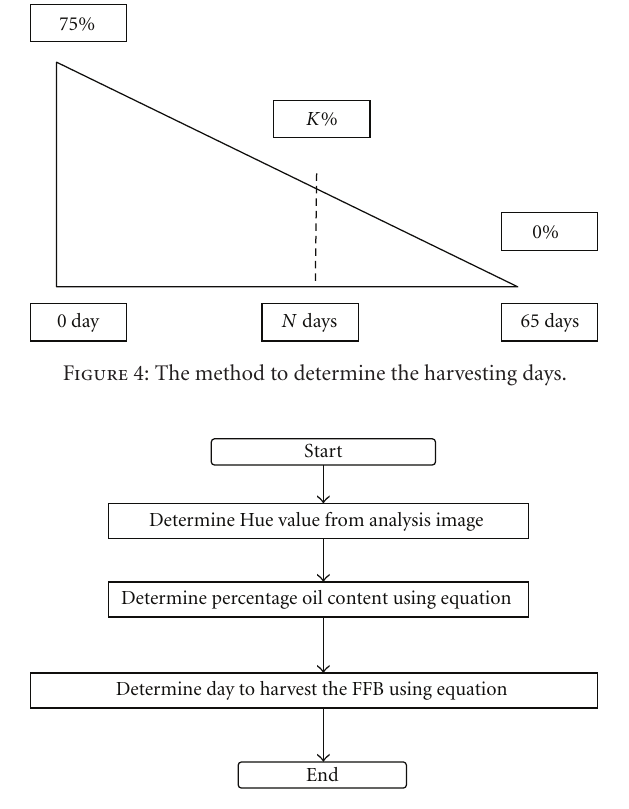
Figure 5: Flow chart for calculating the harvesting day of FFB. Table 1: The correlation of moisture content and weeks of fruits after anthesis (adapted from